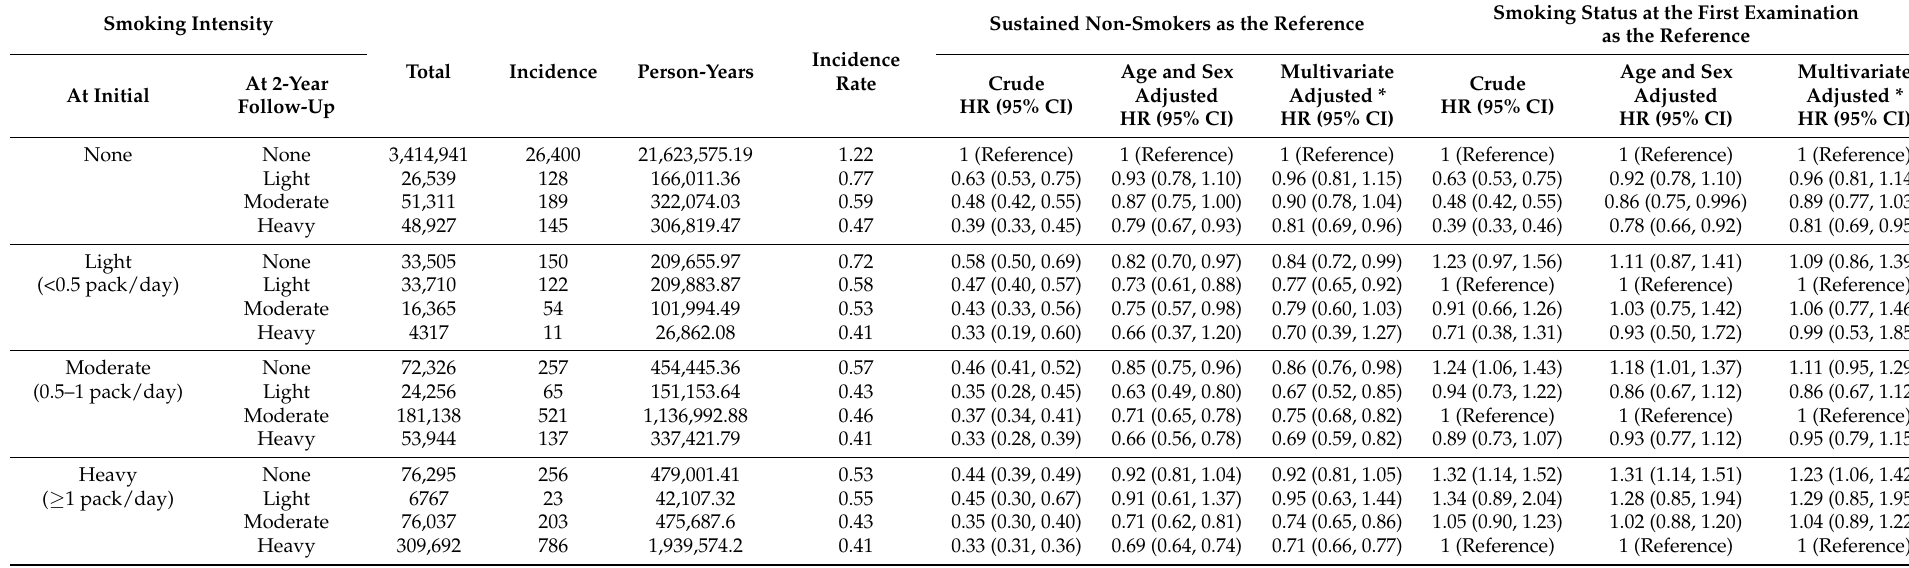
Table 2. Changes in smoking and thyroid cancer risk.